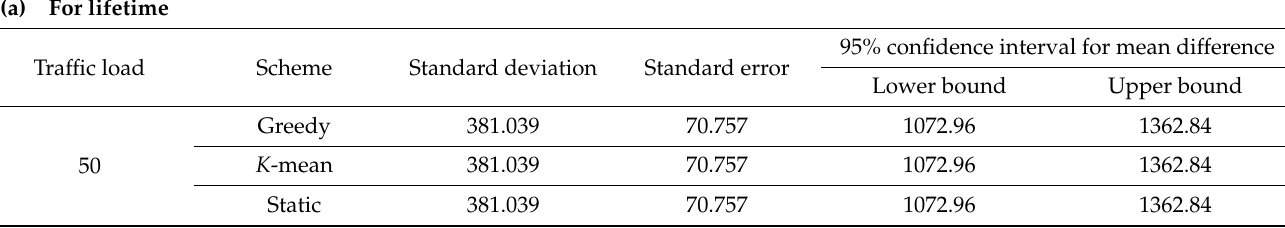
Table 5. The statistical